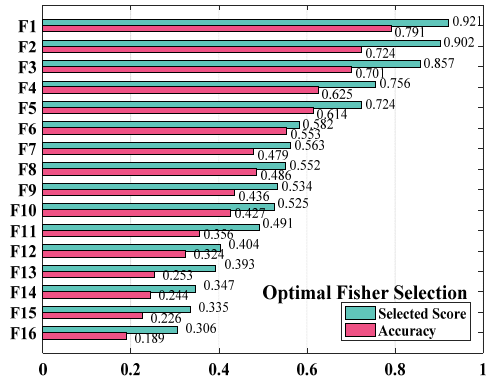
Figure 9. Correlation between features and classification accuracy.